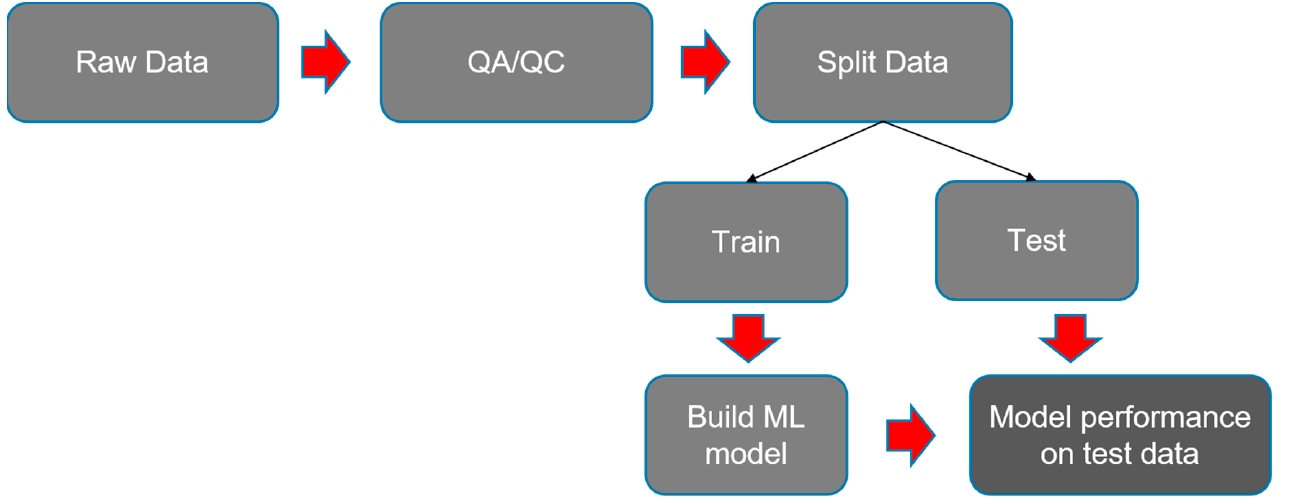
Figure 1. Simple illustration of various steps and their dependence on the machine learning process description.